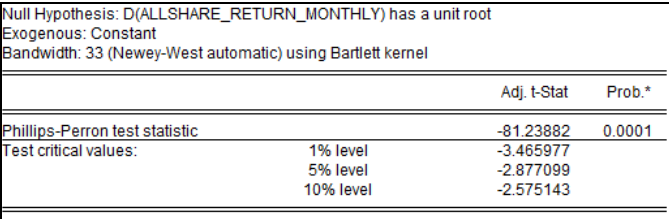
FIGURE 5: Phillips-Perron (PP) Test - First Difference Source: